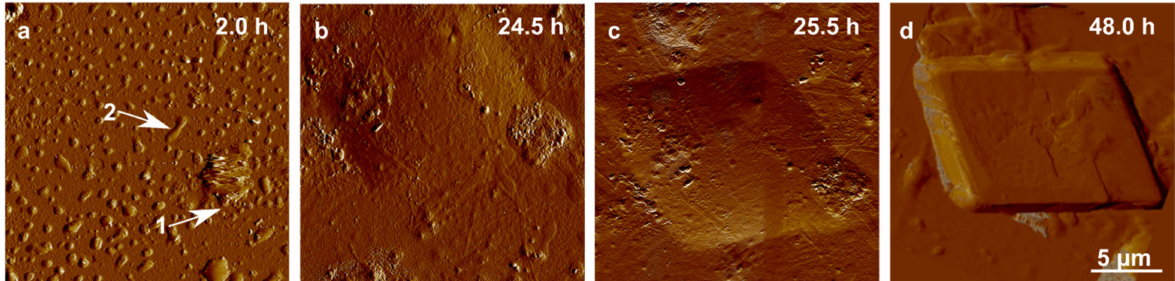
Figure 2. Mesoscopic OZPN-rich clusters on the surface of an OZPN I crystal host the nucleation of a new crystal forms, OZPN DD. AFM monitoring of the cluster evolution. ( a ) Clusters on a (100) face 2 h after introduction to solution. Arrows indicate cluster coalescence, evidence for the liquid composition of the clusters. ( b , c ) Further coalescence of clusters and emergence of facets indicate the nucleation and growth of an underlying crystal. ( d ) A fully developed OZPN DD